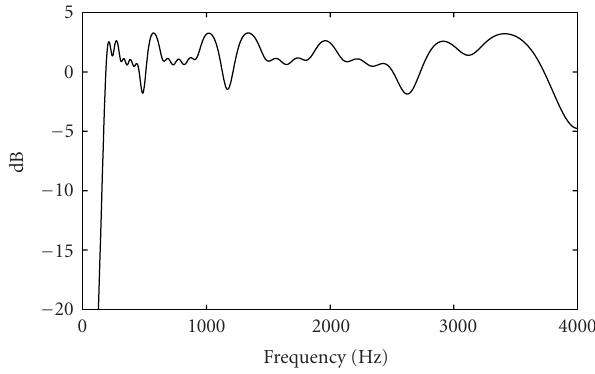
Figure 9: Overall unequalized frequency response of the nondec- imated analysis/synthesis filterbank with channel erasures as in Figure 8.